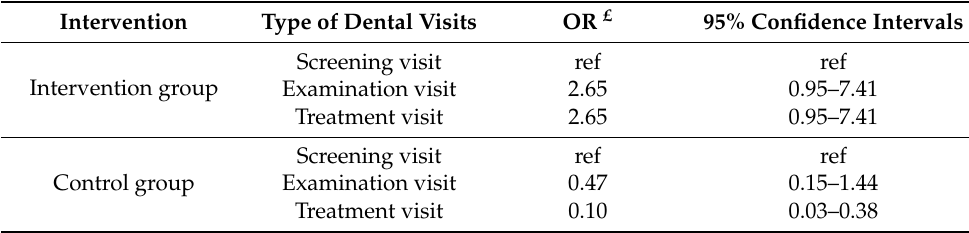
Table 6. The effects of different visits on the Venham scores of each group. Intervention Type of Dental